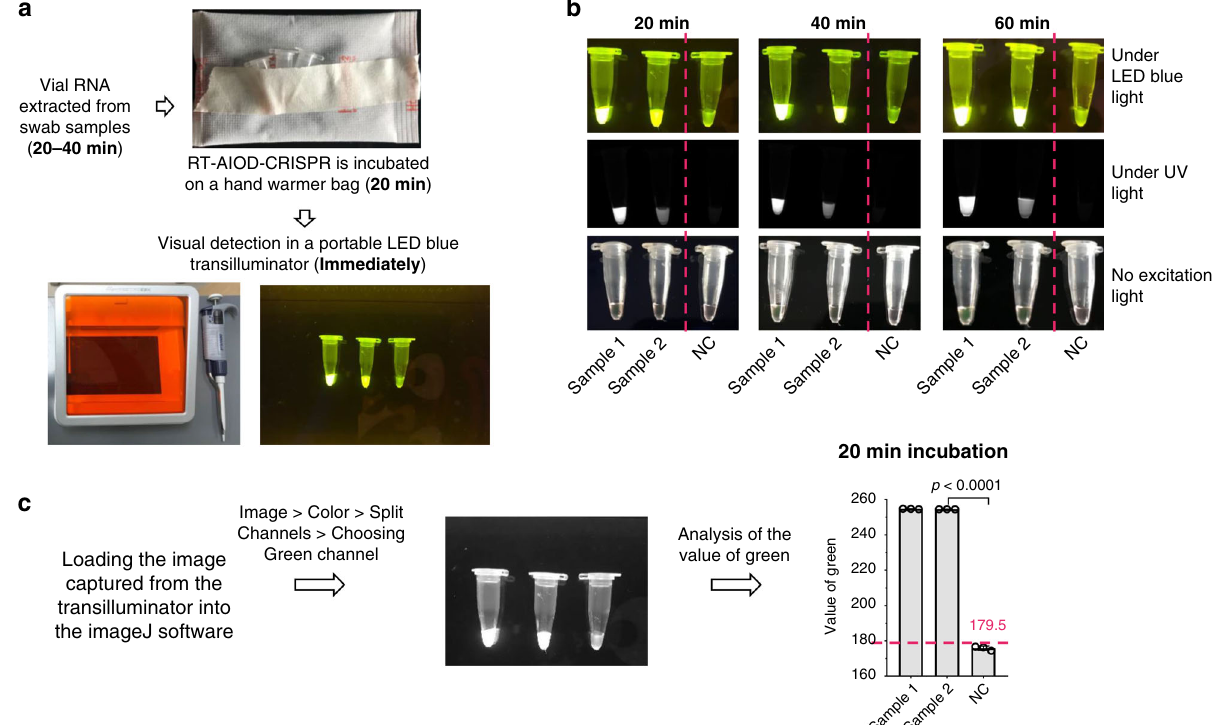
Fig. 5 Instrument-free COVID-19 diagnostics by RT-AIOD-CRISPR assay. a Work fl ow of the instrument-free POC diagnostics. b Visual detection after 20, 40, and 60-min incubation on the hand warmer bag. c Analysis of the green value for the fl uorescence image (20-min incubation) using the ImageJ software. The horizontal dashed line indicates the cutoff fl uorescence that was de fi ned by the average intensity of NTC plus three times of the standard deviation. Source data are provided as a Source Data fi le. NC, the SARS-CoV-2-negative sample. Each measuring was run with three replicates ( n = 3). Error bars represent the means ± s.d. from replicates. The unpaired two-tailed t -test was used to analyze the statistical signi fi cance. Source data is available for c